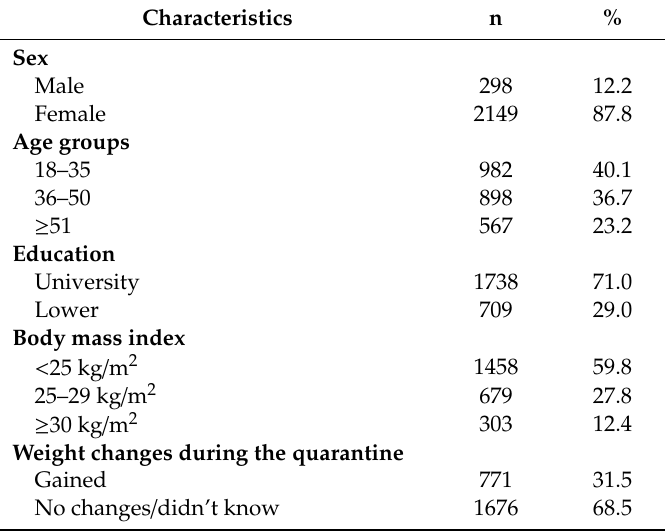
Table 1. Characteristics of the study population